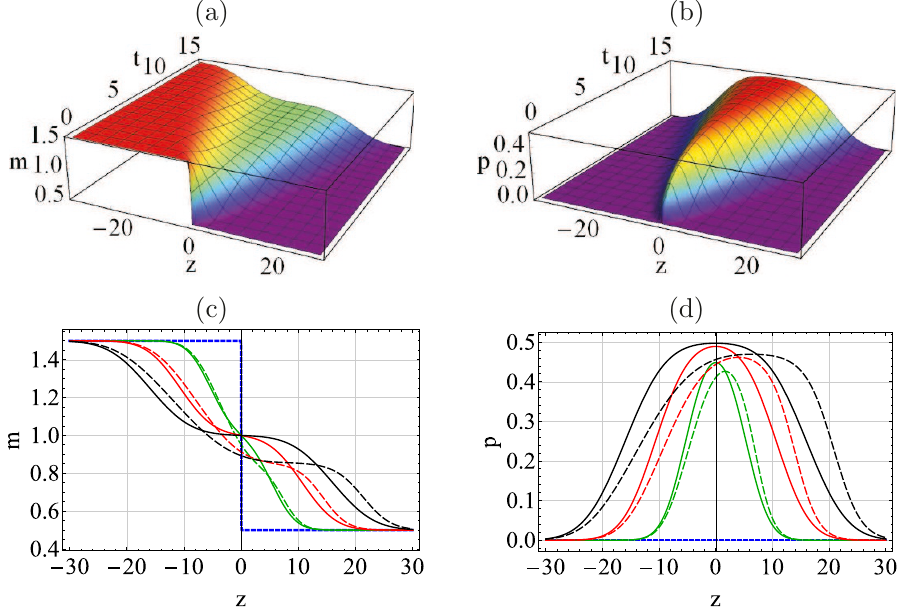
Figure 5 . Three dimensional plots of (a) 1 + m 1 ( t, z ) and (b) p 1 ( t, z ), given by eqs. (3.19) 1 / 2, respectively. The comparison between first-order solution (c) and (3.20) with α = − 1 + m 1 ( t, z ) (resp. (d) p 1 ( t, z )) and full-order numerical solution m ( t, z ) (resp. p ( t, z )), obtained by solving eqs. (2.1) and (3.1). The blue-dashed curve represents initial configuration m (0 , z ) (resp. p (0 , z )). The green, red, and black solid curves represent the first-order solutions at t = 7 . 3, 14, and 22, respectively. The (green, red, and black) dashed curve represents the full numerical solution at the corresponding